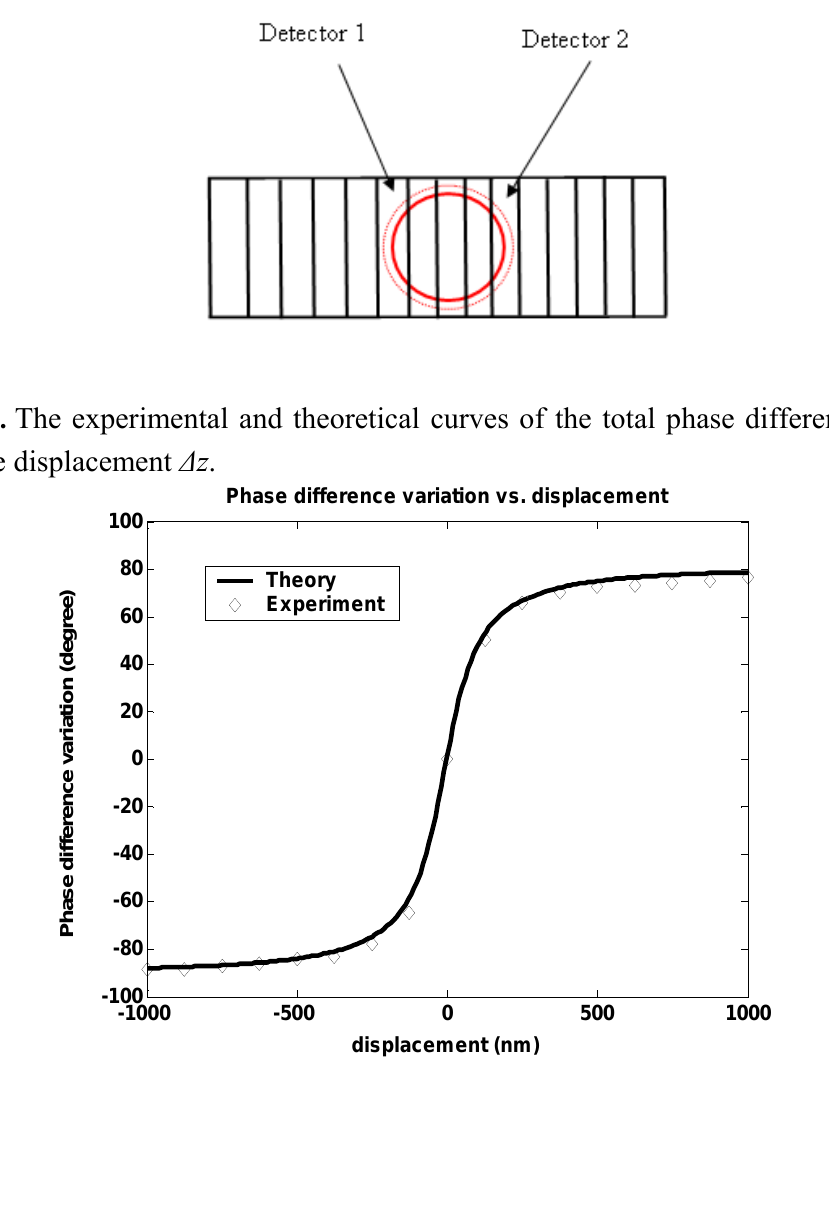
Figure 6. Two marginal rays passing through an analyzer detected by a linear photo-detector.